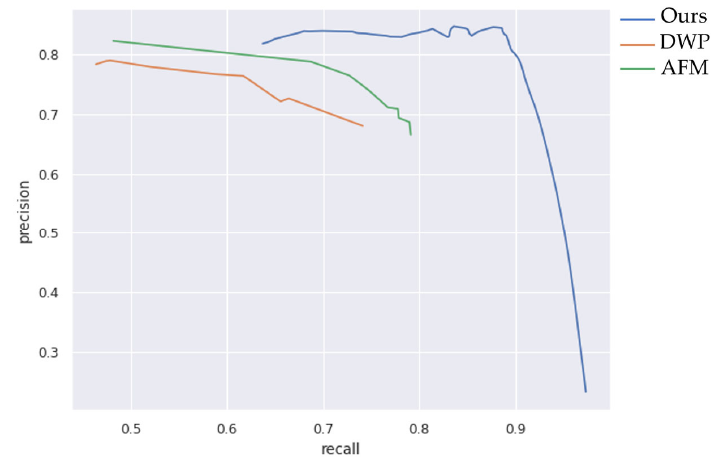
Figure 8. Precision–recall curve of three models.